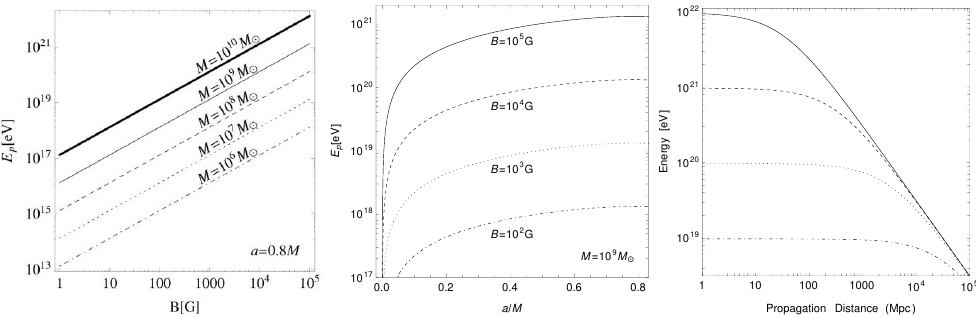
Figure 6. Escaping particles with increasing energy due to increasing magnetic parameter. Suppres- sion of the periodic interval of the chaotic motion increases with increasing magnetic